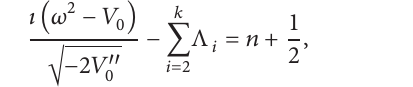
Figure 3: The potential 𝑉 in function of the radius for values 𝑙 = 0 (solid thick line), 𝑙 = 1 (long-dashed line), 𝑙 = 2 (dashed line), 𝑙 = 3 (dot-dashed line), and 𝑙 = 4 (dotted line) for the fixed values of 𝛼 0 = 0.677 , 𝑀 = 1 , and 𝜇 = 0.1𝑀